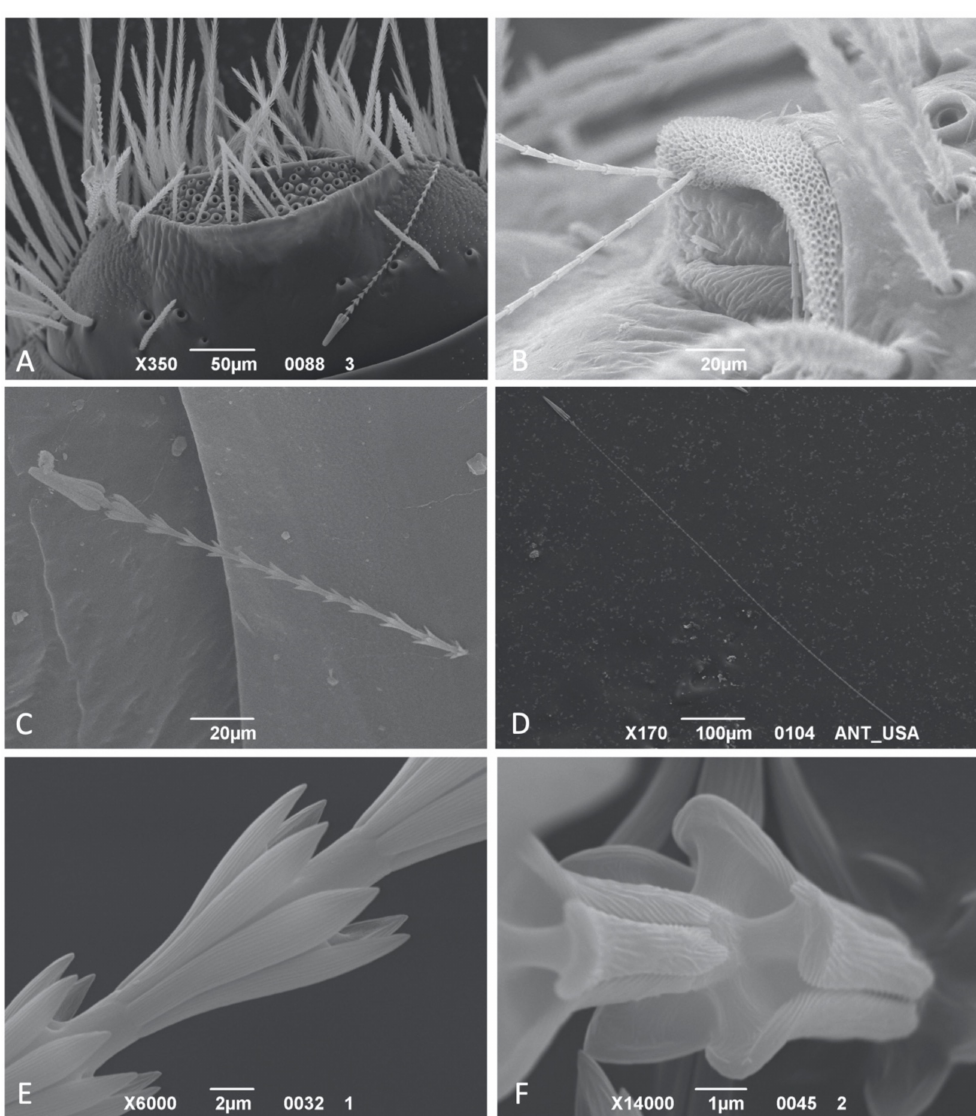
Figure 2. SEM photos of Megatominae larvae: ( A ) Trogoderma spp. 3, dorsal view of the 8th abdominal tergite showing the two patches of detached hastisetae at its corners; ( B ) Anthrenus ( Florilinus ) olgae , detail of the membranous part of the tergite bearing the insertion of the hastisetae; ( C ) Hastiseta of Trogoderma granarium ; ( D ) Hastiseta from the caudal tufts of Anthrenus spp. 1; ( E ) Megatoma undata , lateral view of the rosettes; ( F ) Trogoderma spp. 3, anterolateral view of the rosette showing the chitin bridges supporting the